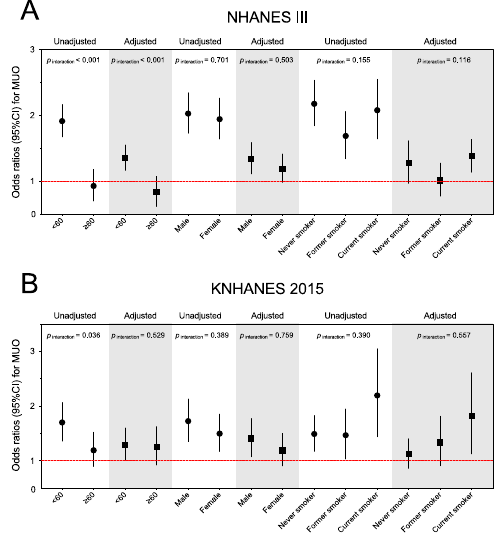
Figure 3. Subgroup analyses for the association between periodontitis and metabolically unhealthy overweight and obese phenotype among the NHANES III ( A ) and KNAHENS ( B ) populations by age, gender, and smoking status. Abbreviations: NHANES III, The Third National Health and Nutrition Examination Survey; KNHANES, Korean National Health And Nutrition Examination Survey; MUO, metabolically unhealthy overweight and obese; CI, confidence interval.